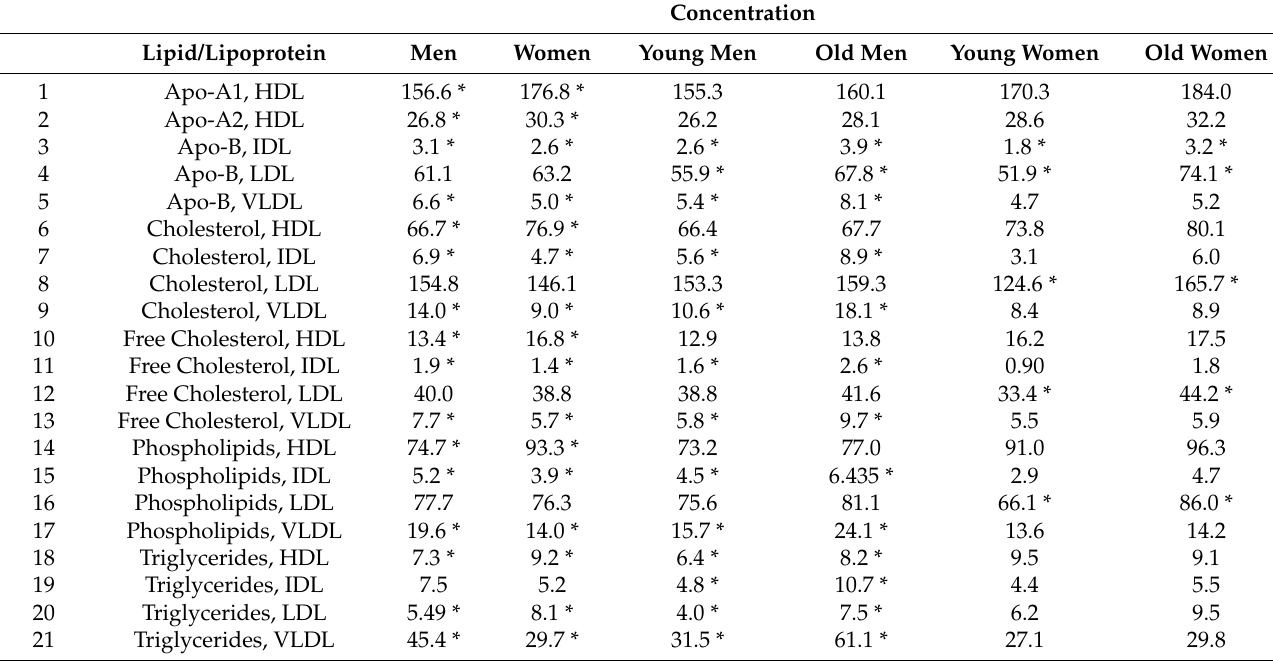
Table 2. Comparison of the concentrations of lipoproteins and lipid main fractions between men and women, young men and old men, and young women and old women (Wilcoxon rank-sum test). * indicates statistically significant differences at α = 0.05 level after Bonferroni correction for multiple testing (actual α = 0.05/21 = 0.0024). Age groups are defined in Table 1. Concentrations are in